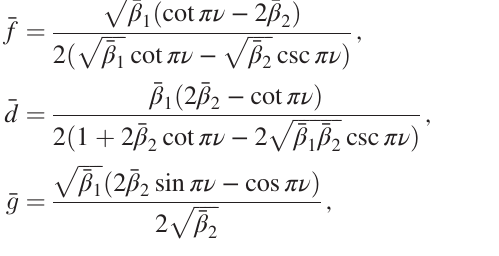
FIG. 5. Dimensionless parameters of the doublet as a function of the betatron tunes with various ratios: ν represented by blue, red, and black color